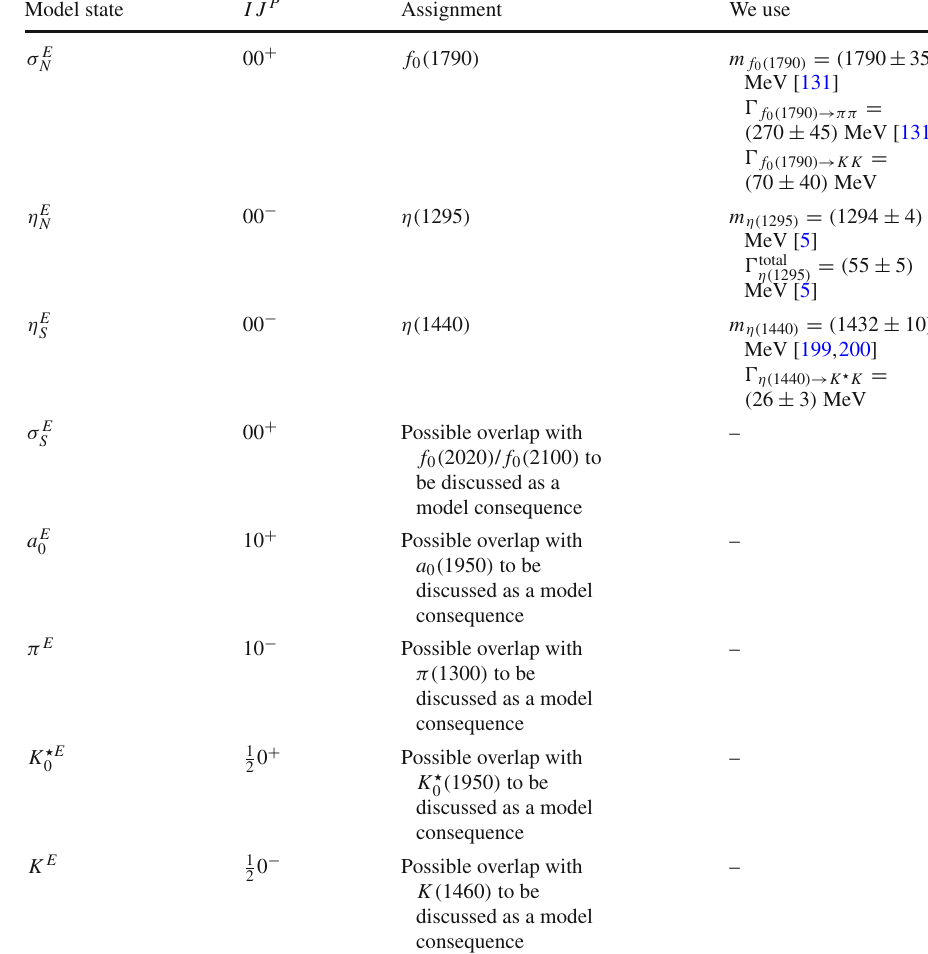
Table 2 Assignment of the states in Eq. (17) to physical states. Every assignment implies the hypothesis that the physical state has the ¯ qq